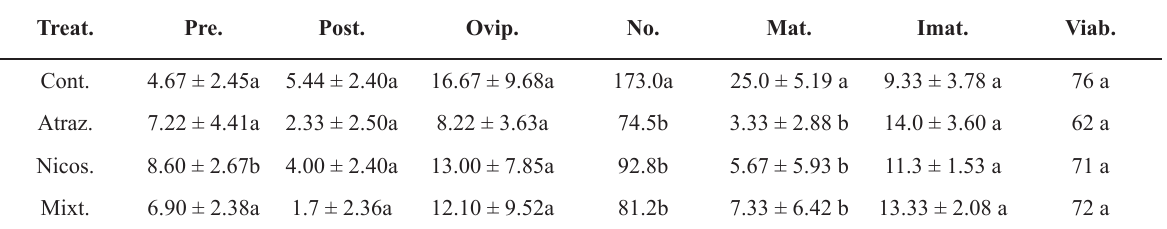
Pre-oviposition (Pre), post-oviposition (Post), oviposition (Ovip.) periods in days and the number of eggs per female (No.) and the numbers of mature (Mat.) and immature (Imat.) oocytes and the viability of eggs (Viab.) (%) of Podisus nigrispinus (Heteroptera: Pentatomidae) in the control sample (Cont.) and the samples exposed to atrazine (Atraz.), nicosulfuron (Nicos.) or a mixture of these herbicides (Mixt.). Treat. Cont. Atraz. Nicos. Mixt. Means per column followed by the same letter do not differ according to the Tukey Test at 5%